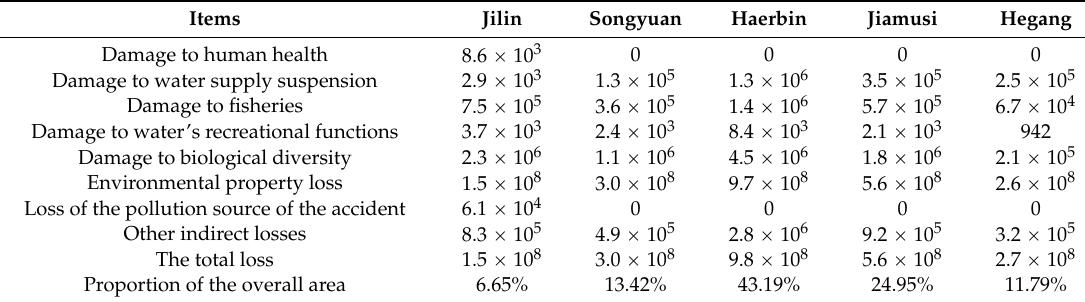
Table 7. The details of the economic loss itemized by region (thousand